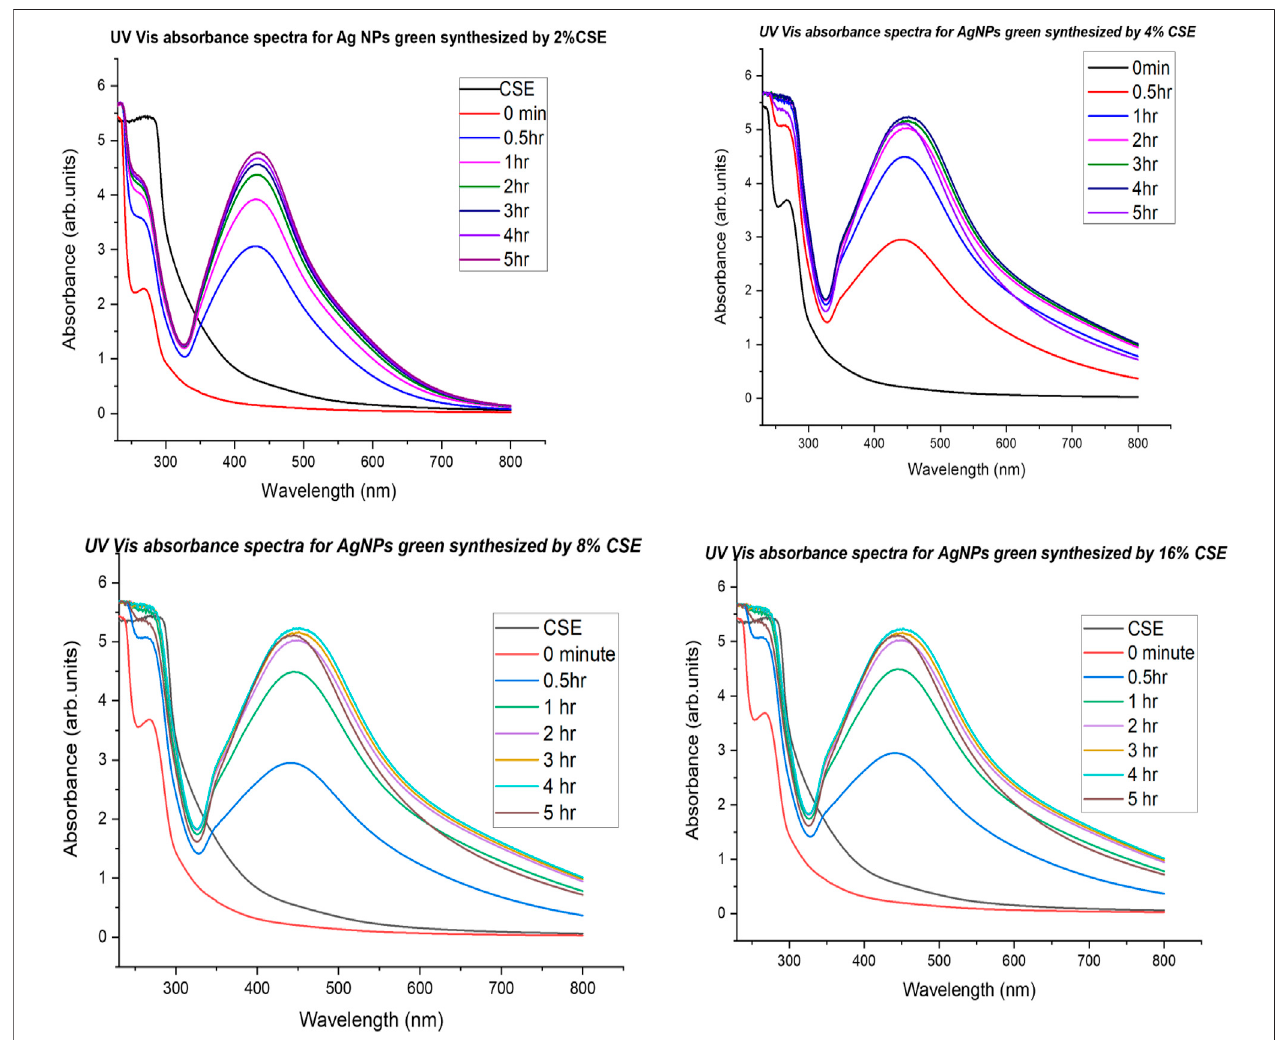
FIGURE 5 | UV-vis absorbance spectra monitoring silver nanoparticles ’ CSE-mediated biosynthesis and stability.